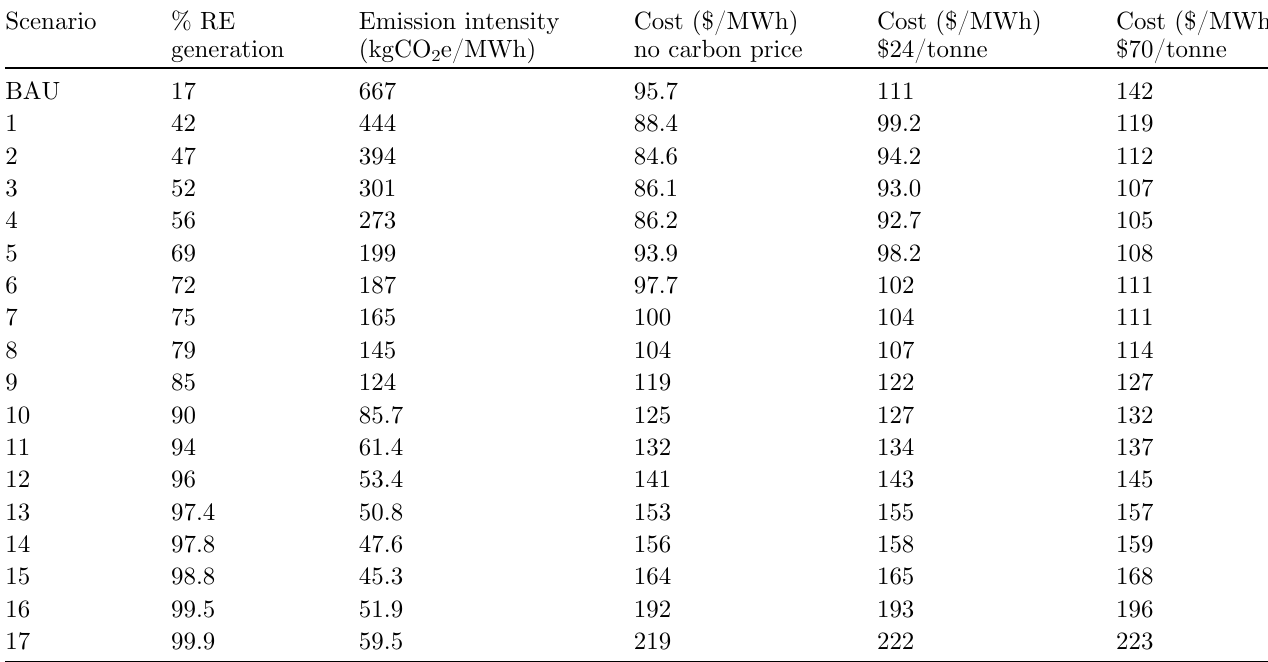
Table 12. Estimated emission intensity and provisional energy cost in $/MWh for each partial renewable scenario for the SWIS electrical grid under different carbon pricing schemes (20 runs).